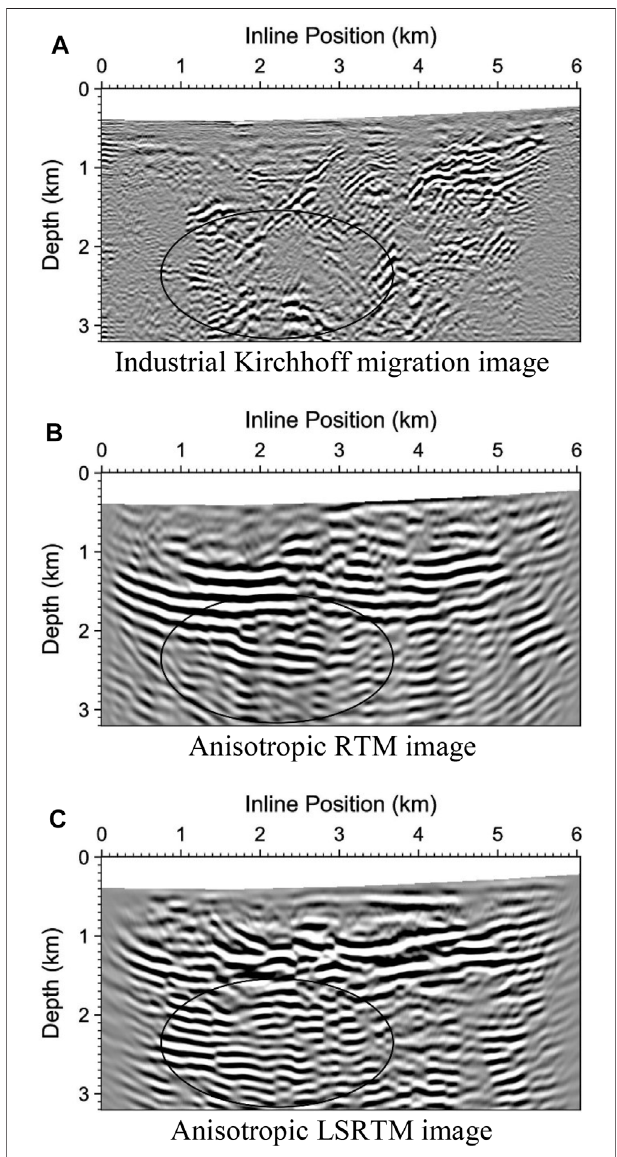
FIGURE 12 | Subsurface migration images of Line 3 at Pirouette Mountain produced using various migration methods: (A) Industrial Kirchhoff migration, (B) Anisotropic RTM, (C) Anisotropic LSRTM. The image within the ellipse region in (C) has higher resolution than that in (B) , and is imaged very poorly in (A)